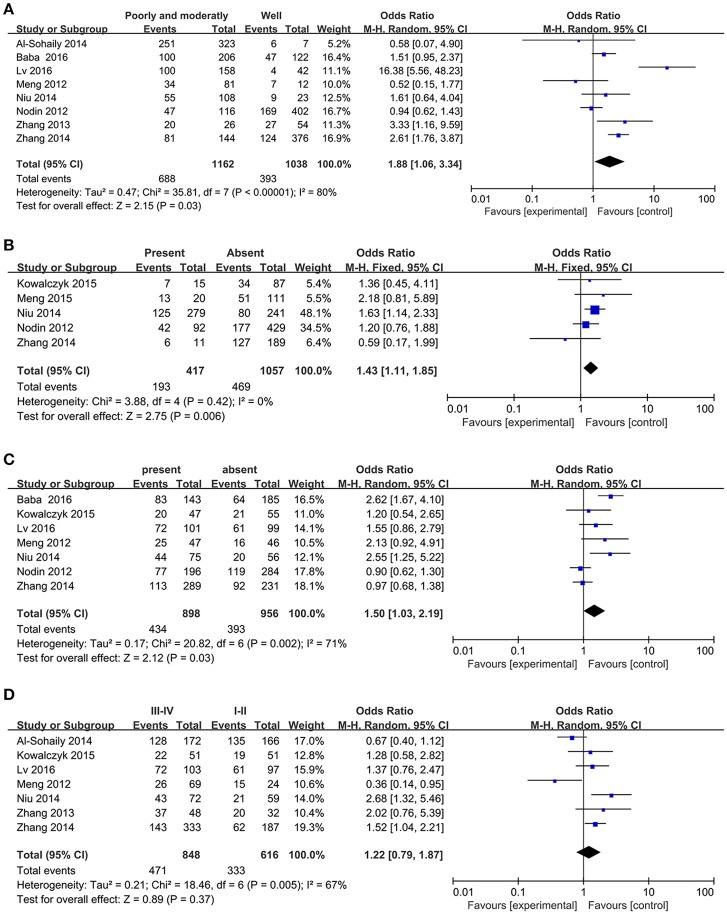
Forest plot for the relationship between SATB1 expression levels with clinical parameters in CRC. (A) Histologic grade; (B) Distant metastasis; (C) Lymph node metastasis; (D) TNM stage.